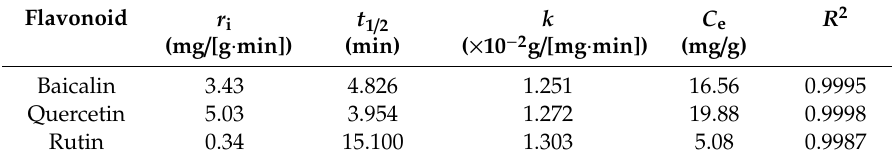
Table 1. Kinetic parameters for flavonoid adsorption.